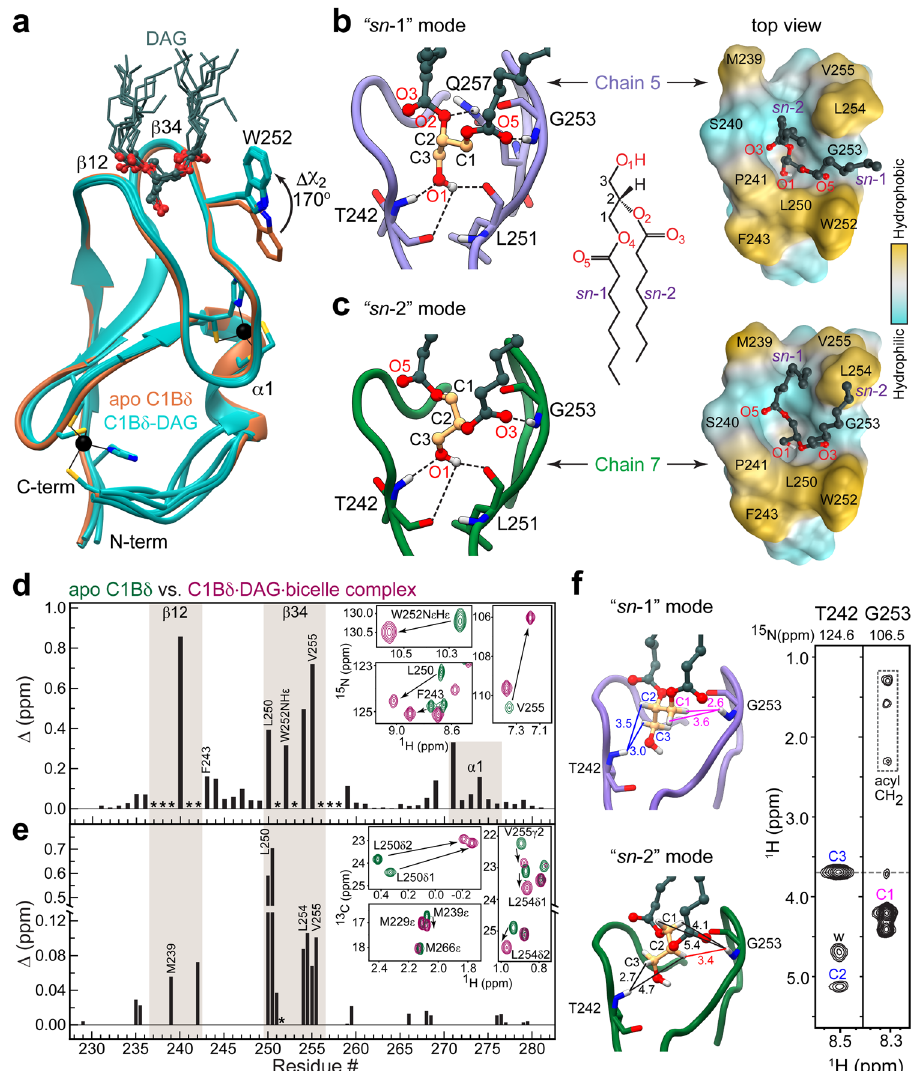
Fig. 2 Stereospeci fi city of DAG binding by C1B δ . a Backbone superposition of 8 DAG-complexed C1B δ chains of the AU (cyan, PDB ID: 7L92) onto the structure of apo C1B δ (sienna, PDB ID: 7KND). The sidechain of Trp252 reorients towards the tips of membrane-binding β 12 and β 34 loops upon DAG binding. DAG adopts one of the two distinct binding modes: “ sn -1 ” ( b ) or “ sn -2 ” ( c ). The formation of the C1B δ -DAG complex in bicelles is reported by the chemical shift perturbations (CSPs) of the amide 15 NH ( d ) and methyl 13 CH 3 ( e ) groups of C1B δ . Asterisks denote residues whose resonances are broadened by chemical exchange in the apo-state. The insets show the response of individual residues to DAG binding through the expansions of the 15 N – 1 H and 13 C – 1 H HSQC spectral overlays of apo and DAG-complexed C1B δ . f 1 H – 1 H 15 N-edited NOESY-TROSY N Thr242 and Gly253 strips from the 3D spectrum of the C1B δ -DAG-bicelle complex. The protein-to-DAG NOE pattern is consistent with the distances observed in the “ sn- 1 ” mode (Chain 5, light purple) but not the “ sn -2 ” mode (Chain 7, green). All distances are in Å and color-coded in the “ sn -1 ” complex to match the labels in the spectrum; “ w ” denotes water protons. The medium-range NOE that would be characteristic of the “ sn -2 ” complex is shown in